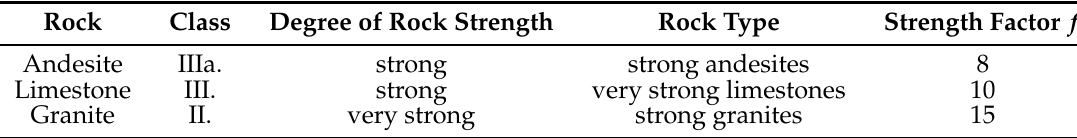
Table 4. Detailed technological properties of the